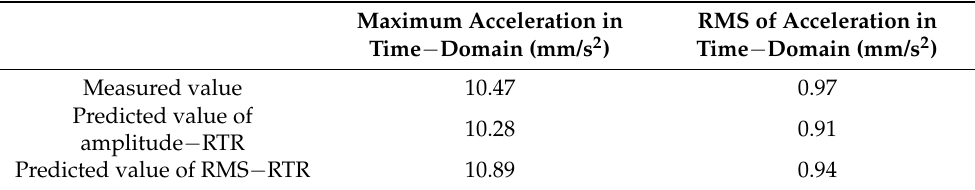
Table 2. Comparison between the predicted and measured acceleration data at the third floor measuring point (D −